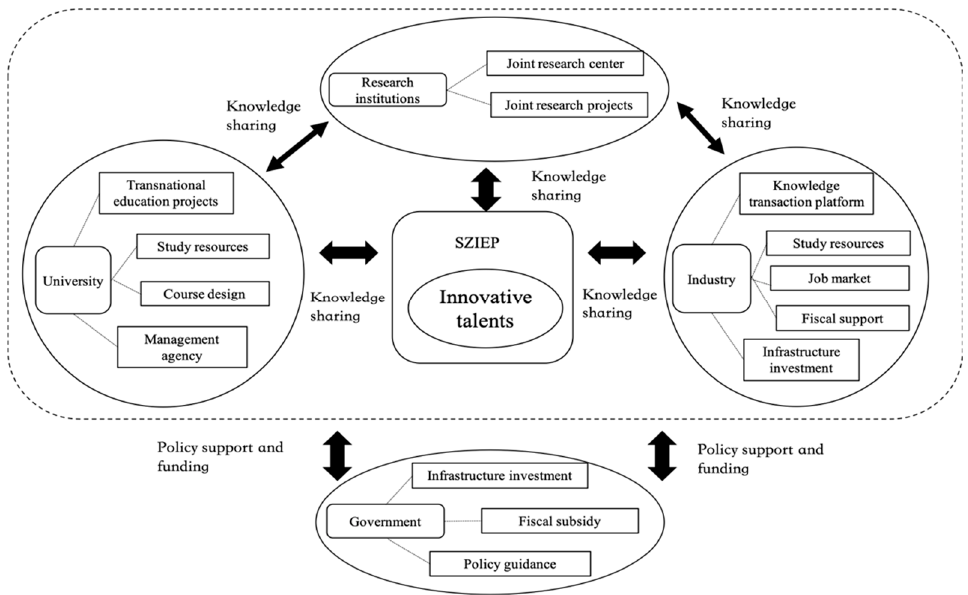
Figure 3. External open innovation ecosystem of SZIEP.